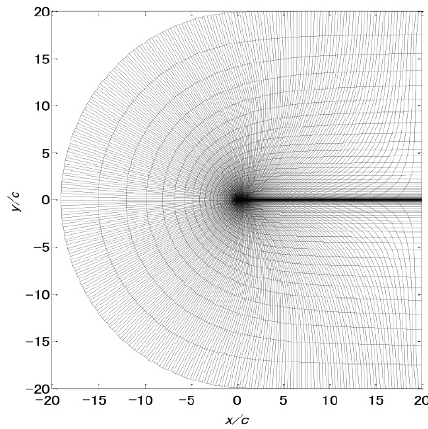
Figure 5. NS Grid (Boundary A).